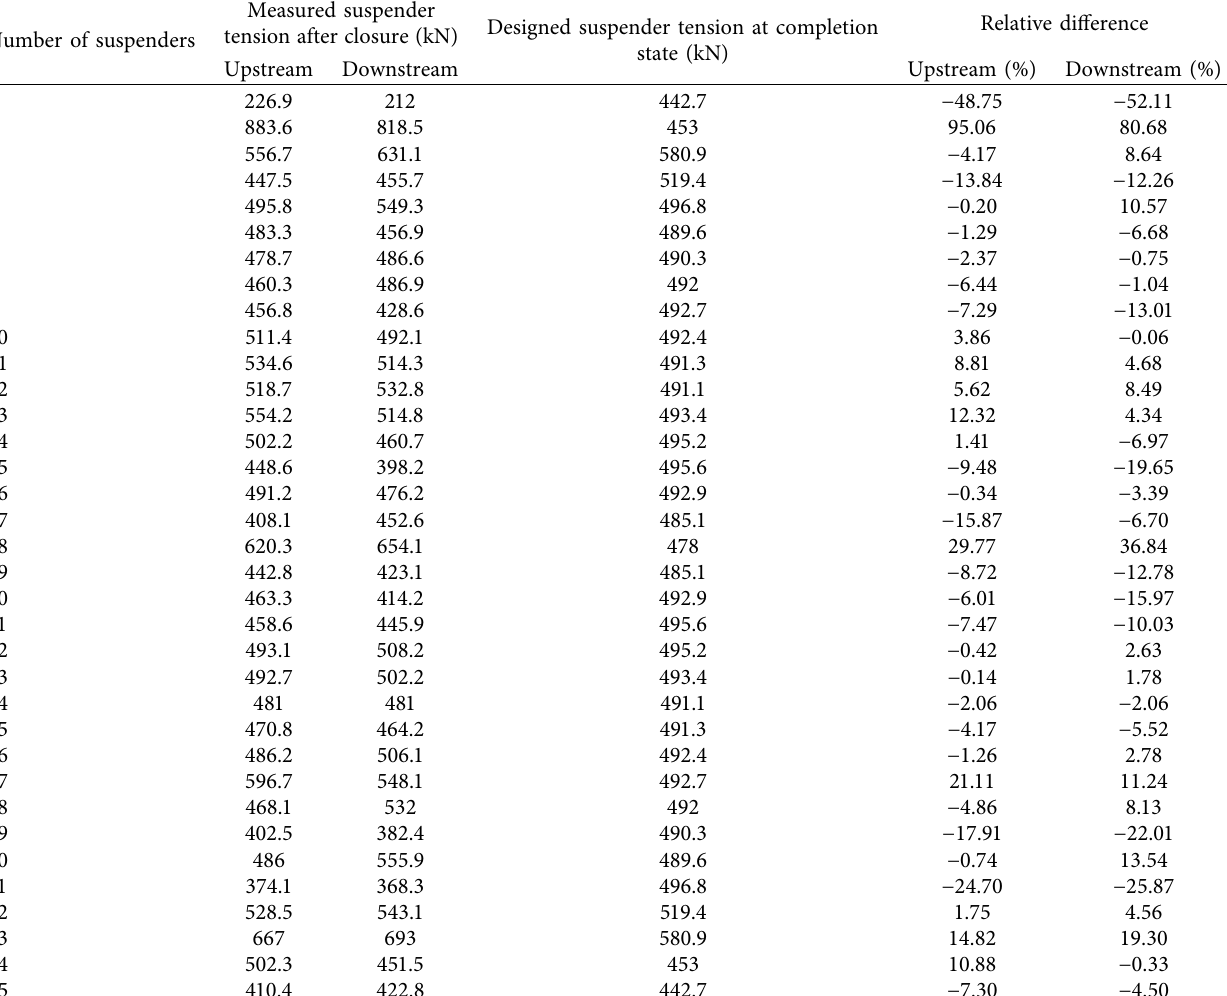
Table 2: Original suspender tension after closure.